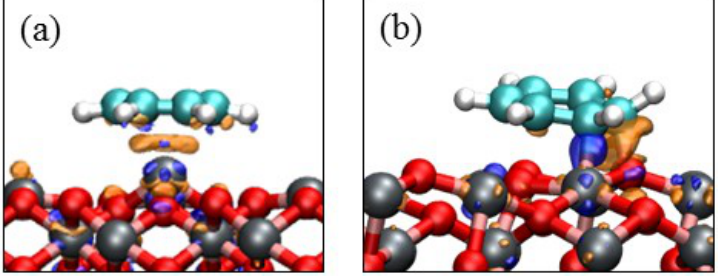
Table 5. The magnetic moments of the interacting surface Fe atoms before and after adsorption of benzene. The bulk hematite Fe magnetic moment is 4.23 μ